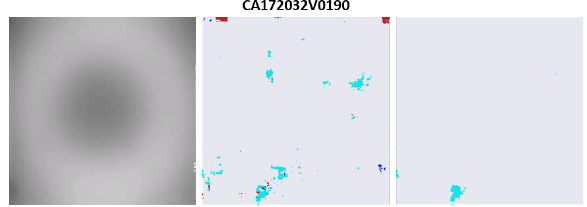
Figure 5. Example for post-processing with raw image (left) and prediction before (center) and after (right)